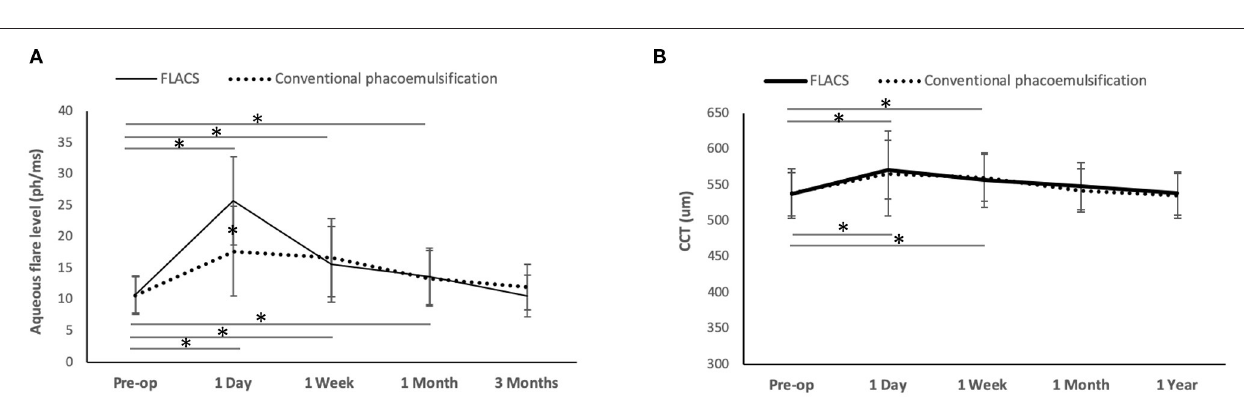
FIGURE 2 | Line graph showing the changes of aqueous flare levels and CCT after FLACS and conventional phacoemulsification. The flare levels significantly increased for one month post-operatively in both groups, and eyes underwent FLACS had significantly greater aqueous flare level than those underwent conventional phacoemulsification at day 1 (A) . The CCT increased significantly at 1 day and 1 week, regardless of the group. There was no significant difference between the two groups in the CCT at all the time points (B) . Error bars indicate standard deviation. * P < 0.05.